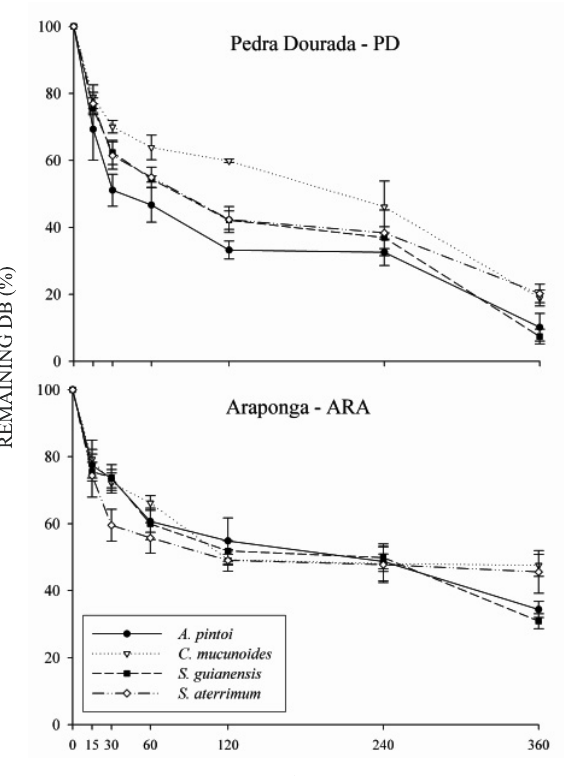
Figure 2. Remaining dry biomass (DB) expressed as the percentage of initial dry weight of the above- ground biomass, in 360 days in the municipalities of Pedra Dourada and Araponga. Vertical bars represent standard error (n =